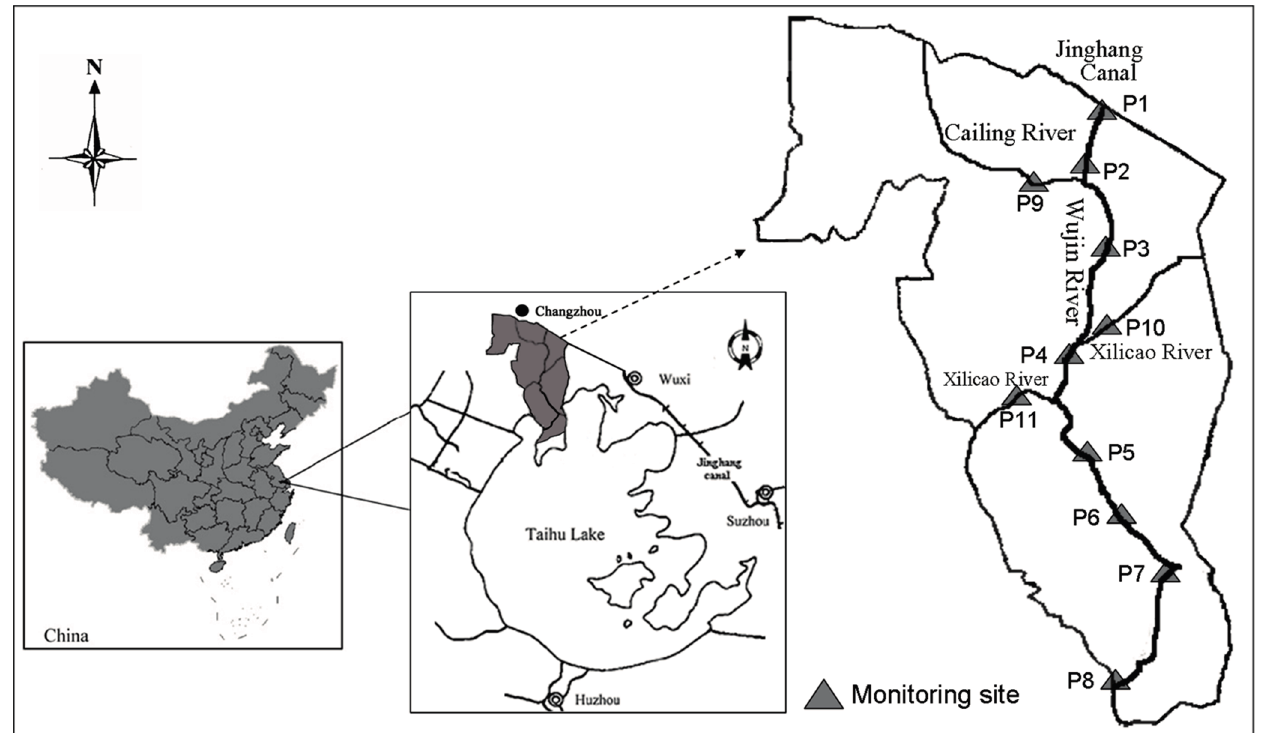
Figure 1. Study area and monitoring sites along the Wujin River.